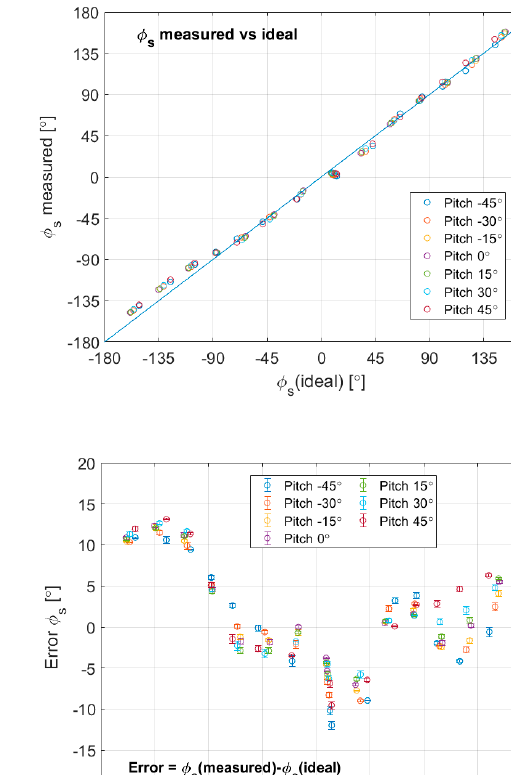
Figure 17. Top : estimated vs. ideal values of the angles of incidence on the sphere for the Aarhus experiment reported in Figures 11 and 12. Bottom : errors in the above estimations. Each point is presented with the 1 σ noise bars associated with the measurement.